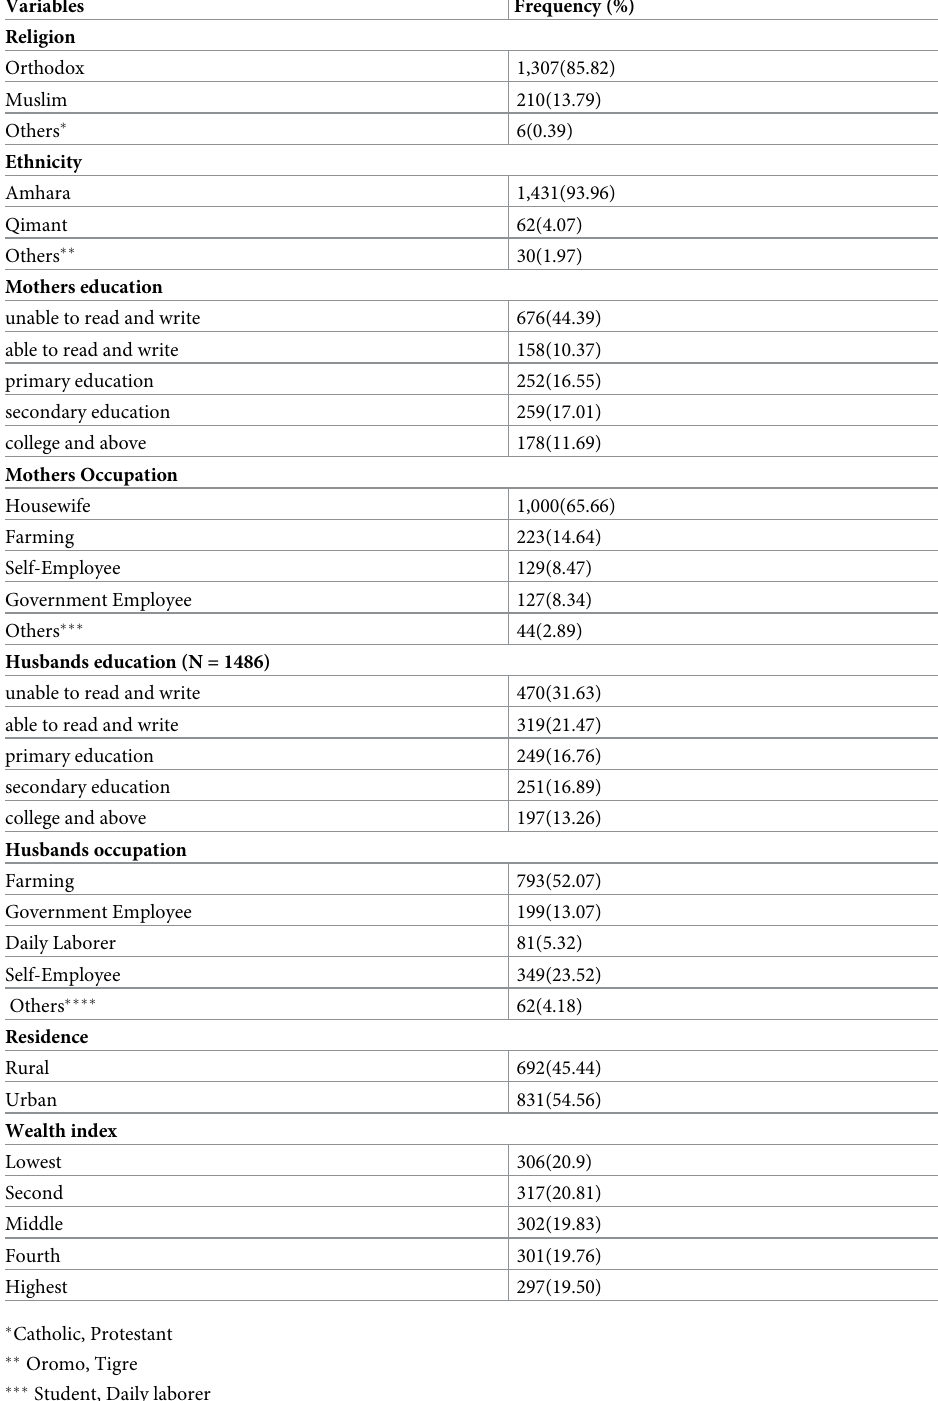
Table 1. Socio-demographic characteristic of study participants at North Gondar Zone, 2018 (n =